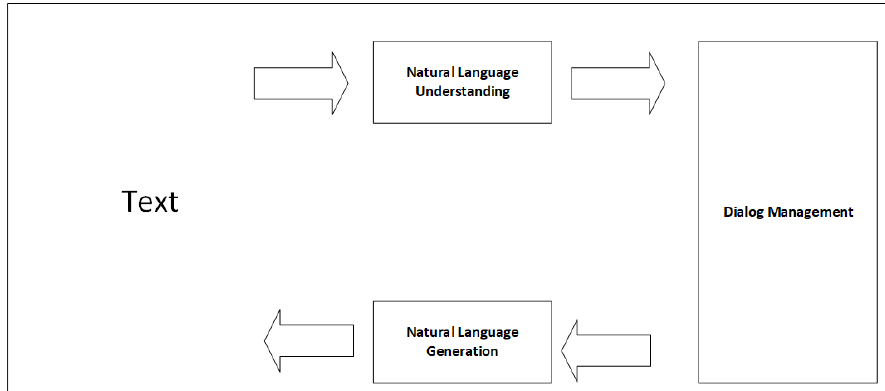
Figure 1. Operation of the task-oriented dialog system.